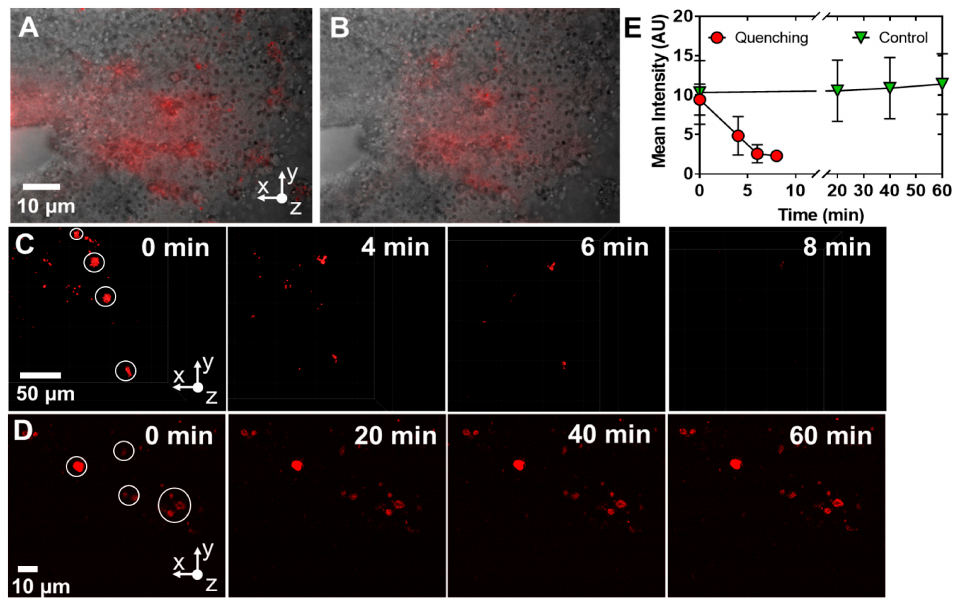
Figure 7. Exogenously applied Zn 2+ rapidly quenches fluorescence. ( A ), A 15 µL volume of nanoparticles was injected into the telencephalon with a picospritzer (cartoon). ( B ), Injection of a 10 µL volume of Zn 2+ at a concentration of 10 µM, resulting in a 41% decrease in total fluorescence within 2s. Image obtained by overlaying fluorescence on brightfield images. ( C ), The brain was perfused with a solution of 100 nM ZnCl 2 in aCSF. ( D ), No Zn 2+ control. For all images, x-axis, caudal; y-axis, lateral; z-axis, ventral. ( E ), Graph of the average intensities of select regions within images in C and D. Regions analyzed are circled.